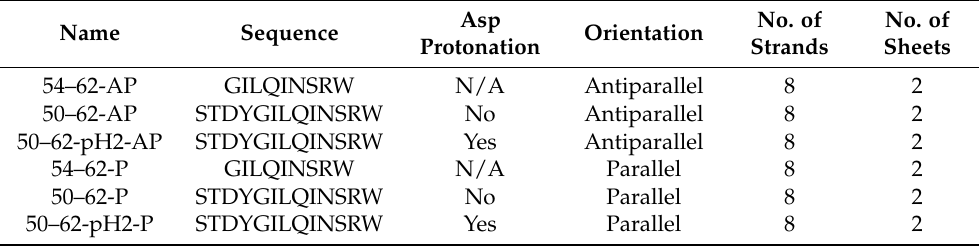
Figure 1. Conformational snapshots of simulated amyloid models after 100 ns MD simulations of ( a ) antiparallel model of K-peptide (54–62-AP), ( b ) antiparallel model of STDY-K-peptide (50–62-AP), ( c ) antiparallel model of protonated STDY-K-peptide at pH 2 (50–62-pH2-AP), ( d ) antiparallel model of K-peptide (54–62-P), ( e ) antiparallel model of STDY-K-peptide (50–62-P), ( f ) antiparallel model of protonated STDY-K-peptide at pH 2 (50–62-pH2-P). Blue color indicated positively charged residues, red color indicated negatively charged residues, green color indicated polar-uncharged residues. Table 1. Nomenclature and information of all simulations of beta amyloids in this study.